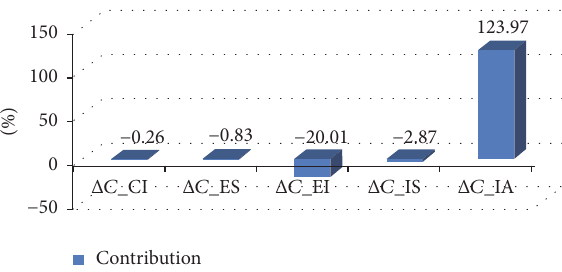
Figure 3: Contribution of each driving factor to CO 2 emission change in China’s power